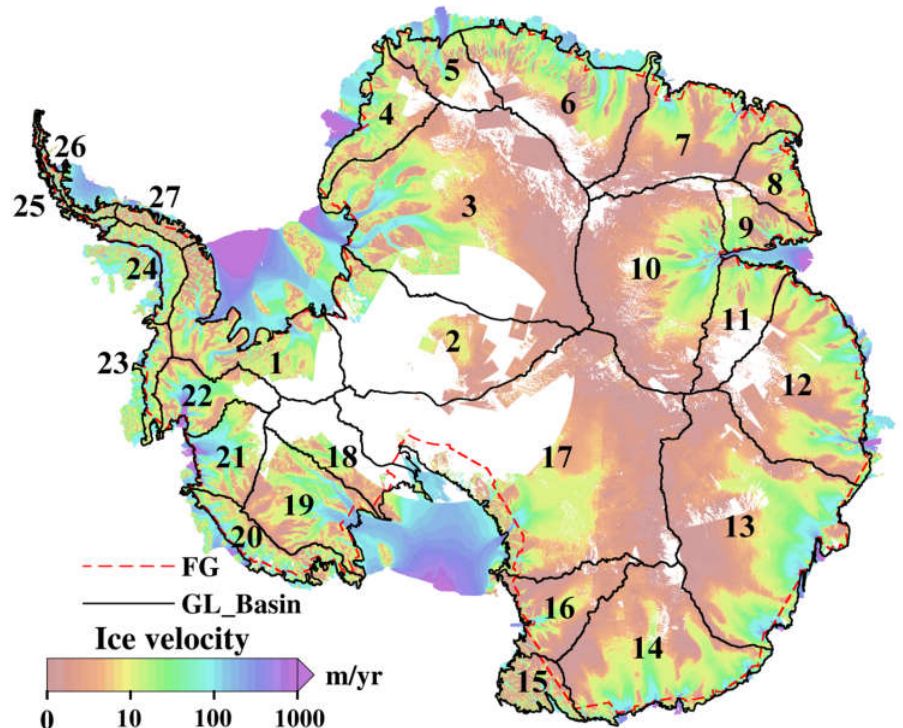
Figure 1. Ice velocity, flux gate (FG), and basin boundaries (B1–B27). The ice velocity is from the MEaSUREs annual ice velocity for 2019–2020 [24]. The red dashed line represents the FG [16], and the solid black line represents the basin boundaries and the grounding line (GL). The numbers 1–27 represent different basins [29].